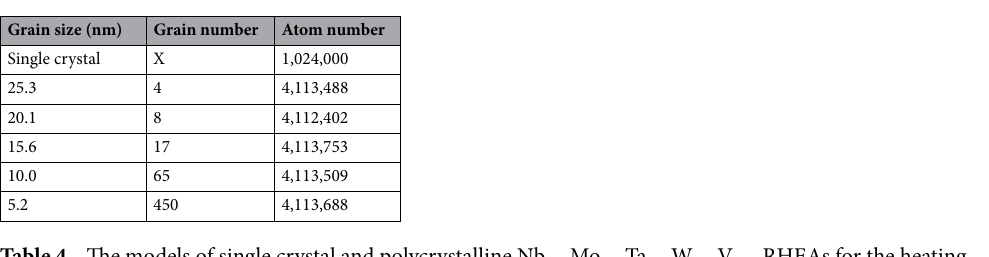
reference atom is not the same as the element type of the reference atom. Because all atoms were arranged by the